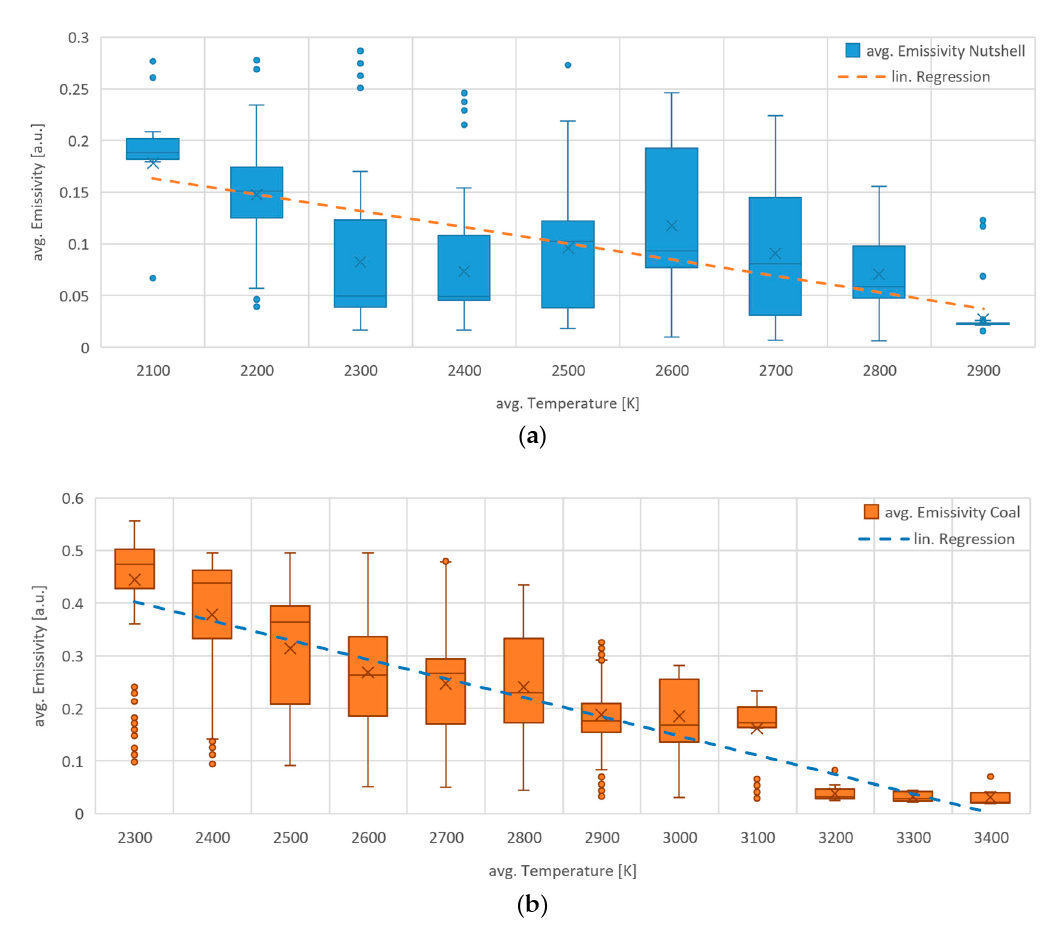
Figure 6. This figure summarizes temperature-dependent averaged emissivity of multiple nutshell ( a ) and coal particles ( b ). and coal particles ( b